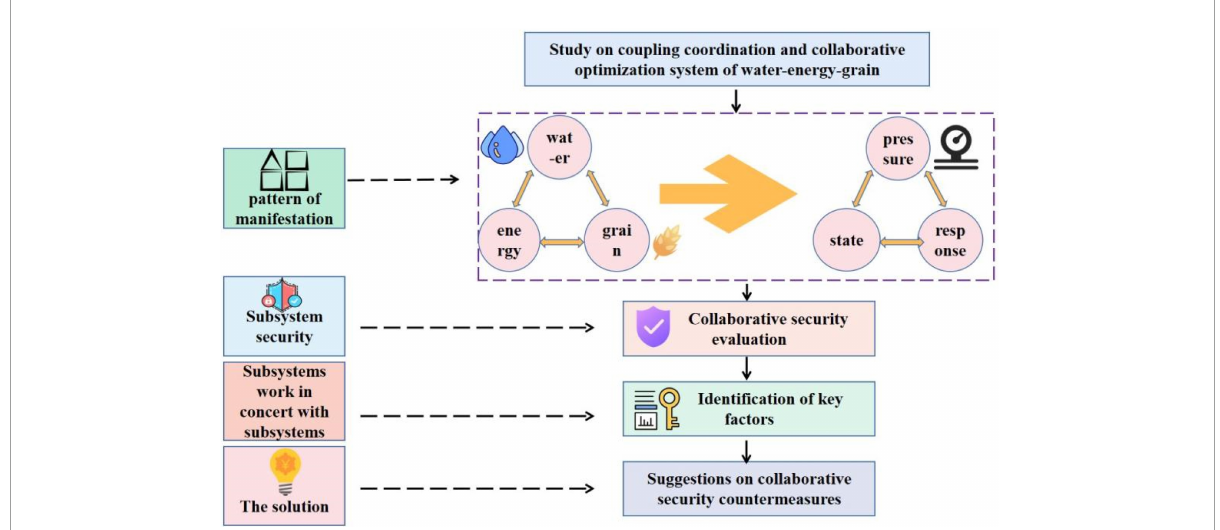
FIGURE2 Collaborative security research framework of water-energy-food related system.